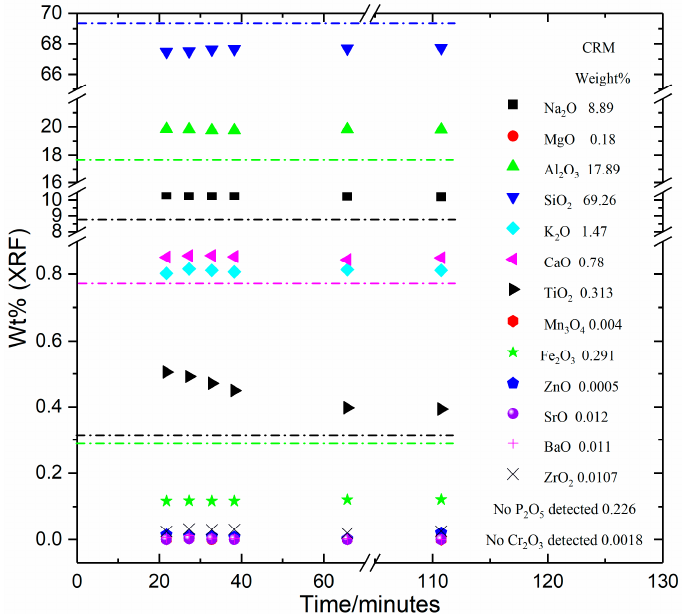
Figure 3. XRF OXI results for CRM-375 [43] (Soda Feldspar) as a function of total process time. Error bars are smaller than the data markers. Horizontal lines indicate the certified composition of CRM-375. Analysed TiO 2 content includes contribution from I L β 1,2,3 lines.